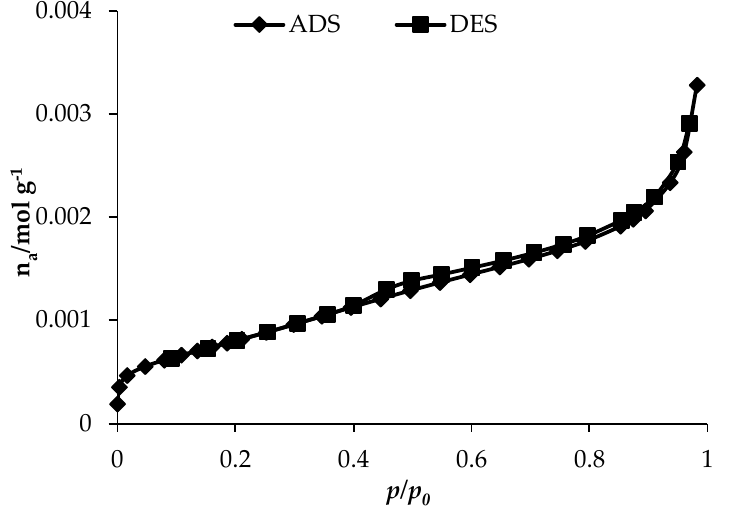
Figure 7. N 2 adsorption/desorption isotherms of the 0.1Fe-TiO 2 -300